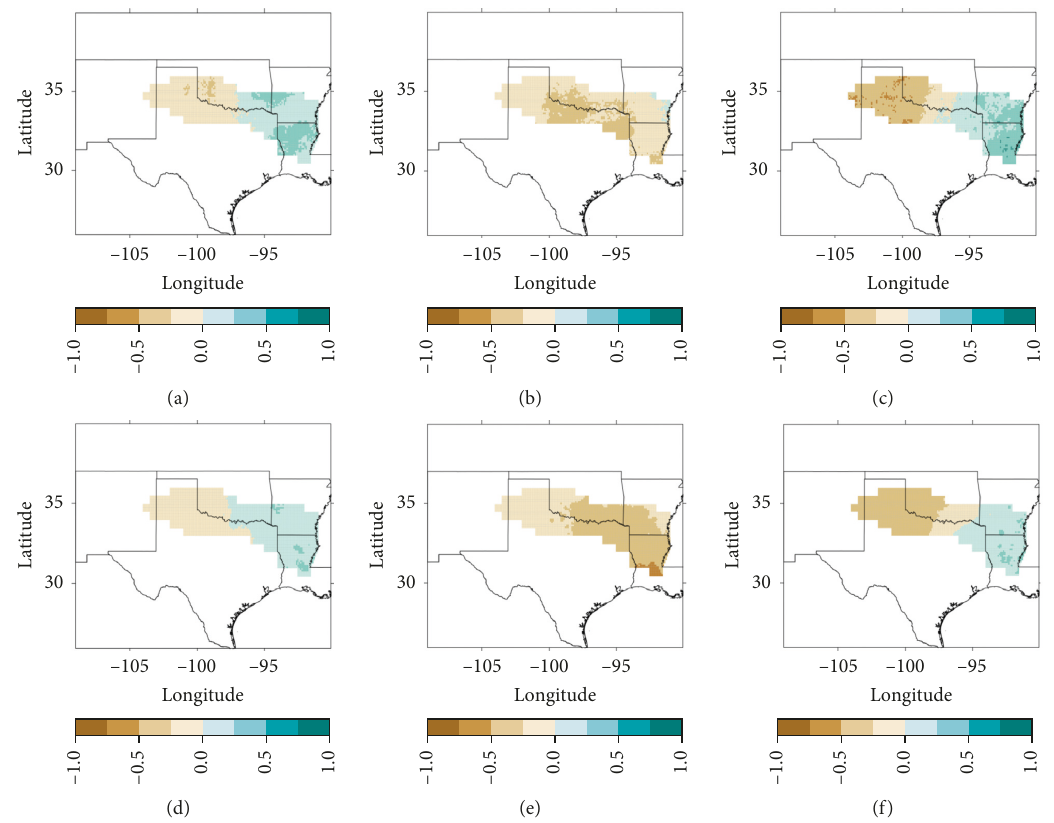
Figure 3: Difference fields for mean daily precipitation (in mm/day) between historical (1981–2005) and end-of-century (2075–2099) time frames for RCP 8.5. Columns represent the GCMs (CCSM4, MIROC5, and MPI-ESM-LR, from left to right respectively); rows represent downscaling methods, with CDFt on top and EDQM on bottom. Brown and tan colors represent future decreases in precipitation compared to the historical period; blue-green colors represent future increases in precipitation. (a) Model: CCSM4, SD: CDFt. (b) Model: MIROC5, SD: CDFt. (c) Model: MPI-ESM-LR, SD: CDFt. (d) Model: CCSM4, SD: EDQM. (e) Model: MIROC5, SD: EDQM. (f) Model: MPI-ESM-LR, SD: EDQM.